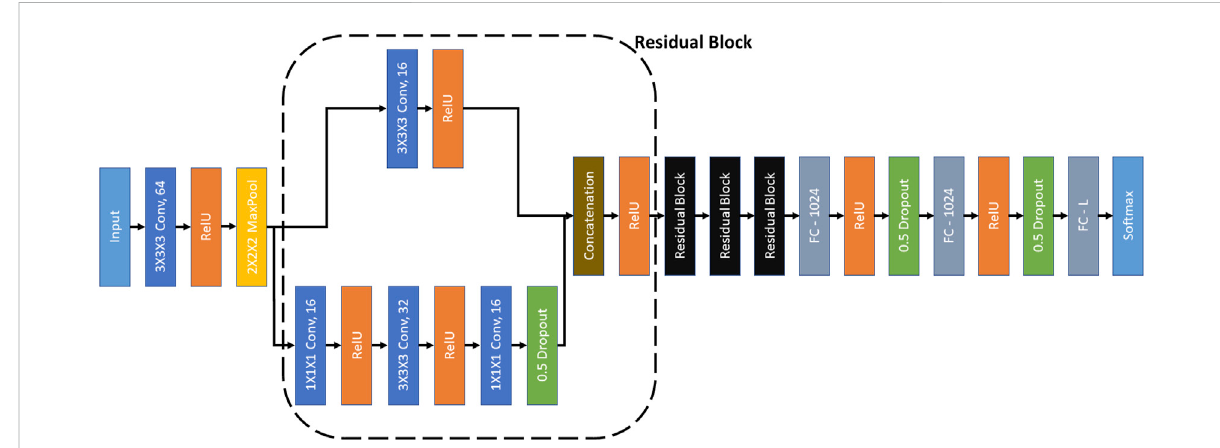
FIGURE 3 RB3D model (Che et al., 2018). ‘ 3×3×3 Conv, 64 ’ represents a 3D convolutional layer with kernel dimensions 3×3×3 and 64 fi lters. Other convolutional layers follow similar de fi nitions. All the convolutional layers have a stride of 1. ‘ 2×2×2 MaxPool ’ represents a max-pooling operation over the input signal with kernel size 3×3×3 and stride of 2. ‘ Concatenation ’ denotes the concatenation of the fi lters of the same dimensions. ‘ FC- 1024 ’ represents a fully connected layer with 1024 neurons. The ‘ L ’ in ‘ FC-L ’ corresponds to the output dimension. ‘ RelU ’ and ‘ Softmax ’ are activation